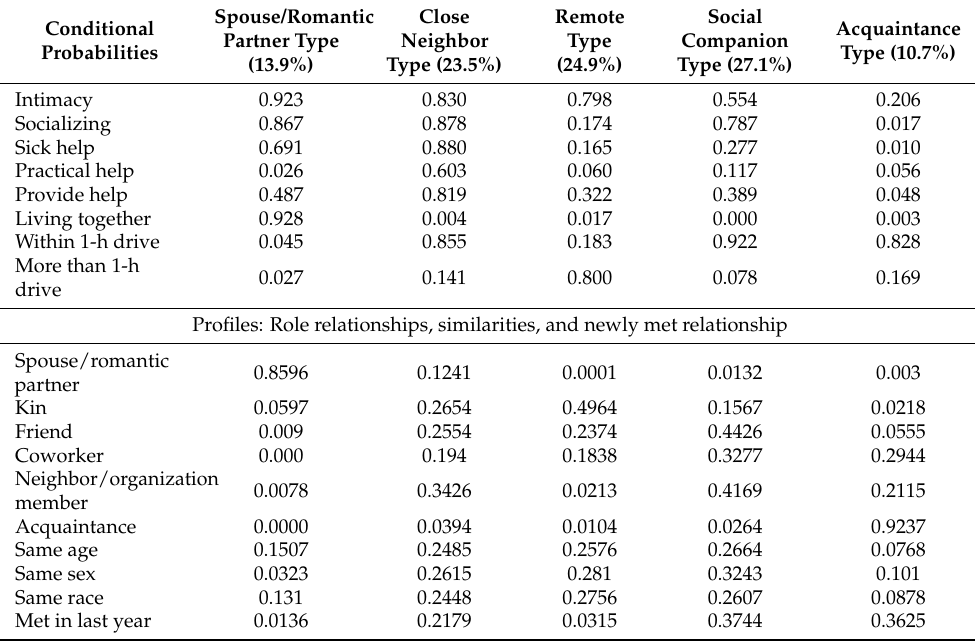
Table A2. Conditional probabilities and profiles for five types of discussion partner ties.